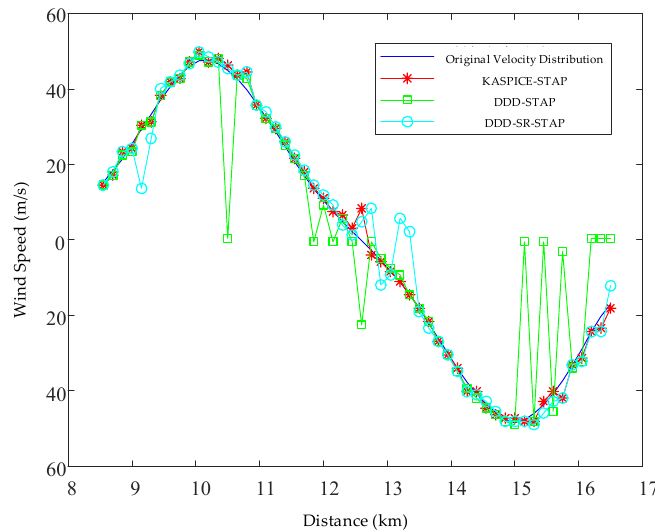
Figure 9. Comparison of low-altitude windshear wind speed estimation.